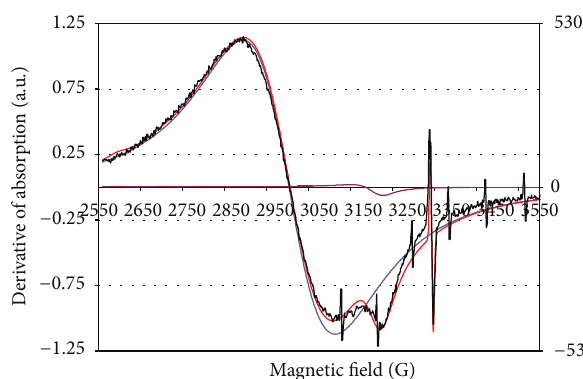
Figure 9: EPR spectrum type IV ( < 10mol%